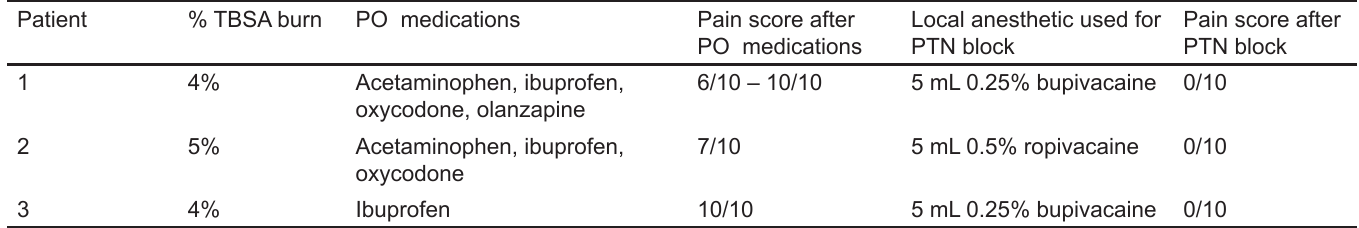
Table. Patient pain scores after oral analgesia and after posterior tibial nerve block. Patient